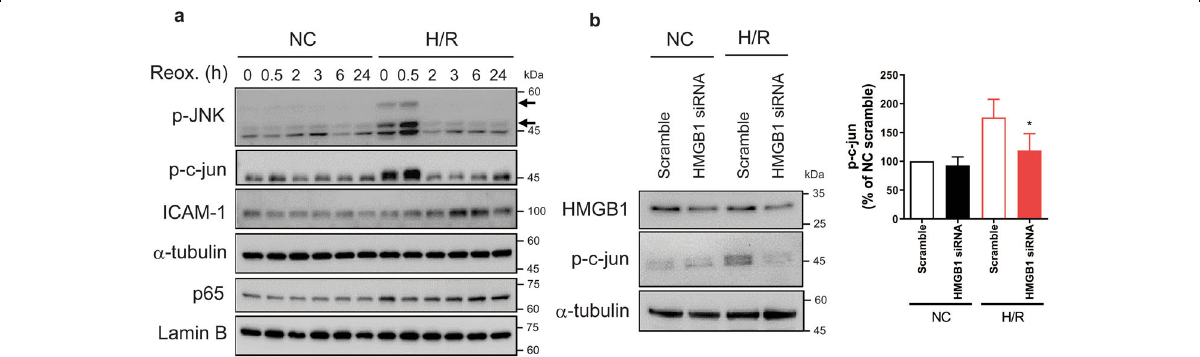
Fig. 2 H/R activated JNK signalling and HMGB1 regulated c-Jun activation in HBMVECs. a HBMVECs were exposed to H/R for the indicated times. The expression levels of phosphorylated JNK (p-JNK(T183/Y185), arrows) and phosphorylated c-jun in total lysate, ICAM1 in the cytosolic fraction, and the translocation of p65 in nuclear fractions were analysed; α -tubulin and lamin B were used as loading controls. Representative blots from triplicated experiments are presented. b HBMVECs were transfected with scrambled siRNA (scramble) or siRNA targeting the HMGB1 gene (HMGB1 siRNA). After 24 h of transfection, HBMVECs were exposed to 24-h H/R or normoxia, and the level of intracellular p-c-Jun was analysed by western blotting; α -tubulin was used as a loading control, and representative blots are presented. Bar graph indicate the relative expression level of p- c-jun when compared with NC cells transfected scrambled siRNA ( n = 4, mean ± SD; * p < 0.05 versus H/R scrambled siRNA group by unpaired t-